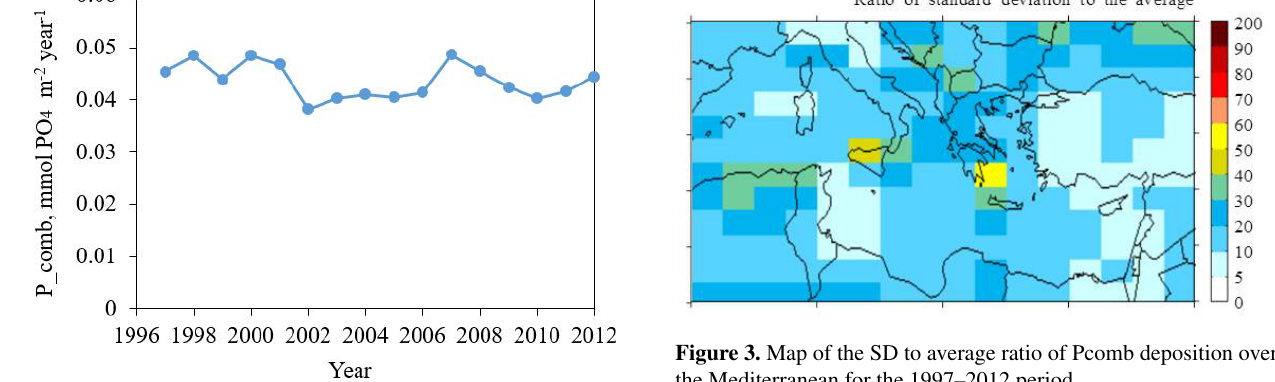
Figure 2. Plot of yearly average Pcomb deposition over the Mediterranean for the 1997–2012 period.